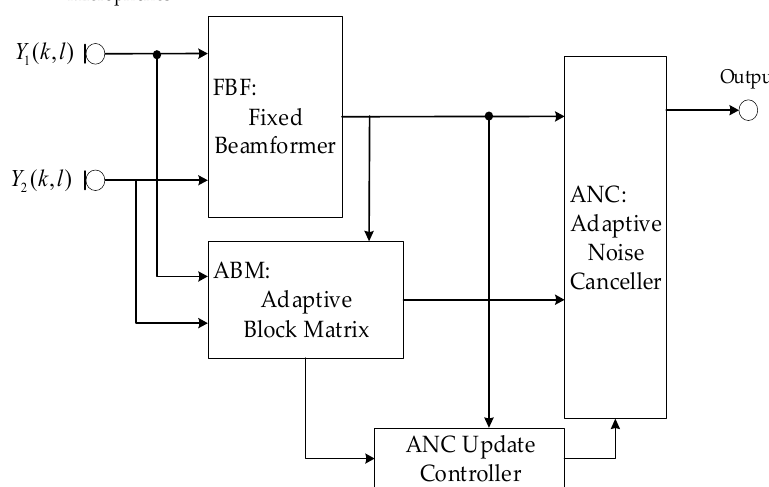
Figure 3. The robust generalized sidelobe canceller (GSC) with coefficients constrained ABM structure.